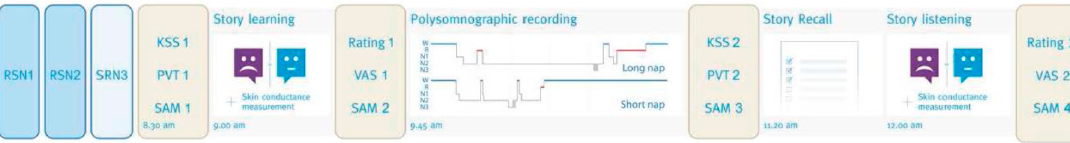
Figure 1. One week prior to the session, participants received an actimeter and were given instructions to keep regular sleep schedules, follow their usual bedtimes, and wake up 2 h earlier than their usual wake time on the day of the testing session. On the session day, participants arrived at the sleep laboratory at 8:00 a.m. After being prepared for polysomnographic (PSG) recording, they were asked to wash their hands to obtain an optimal skin conductance signal. At 8:30 a.m., subjective